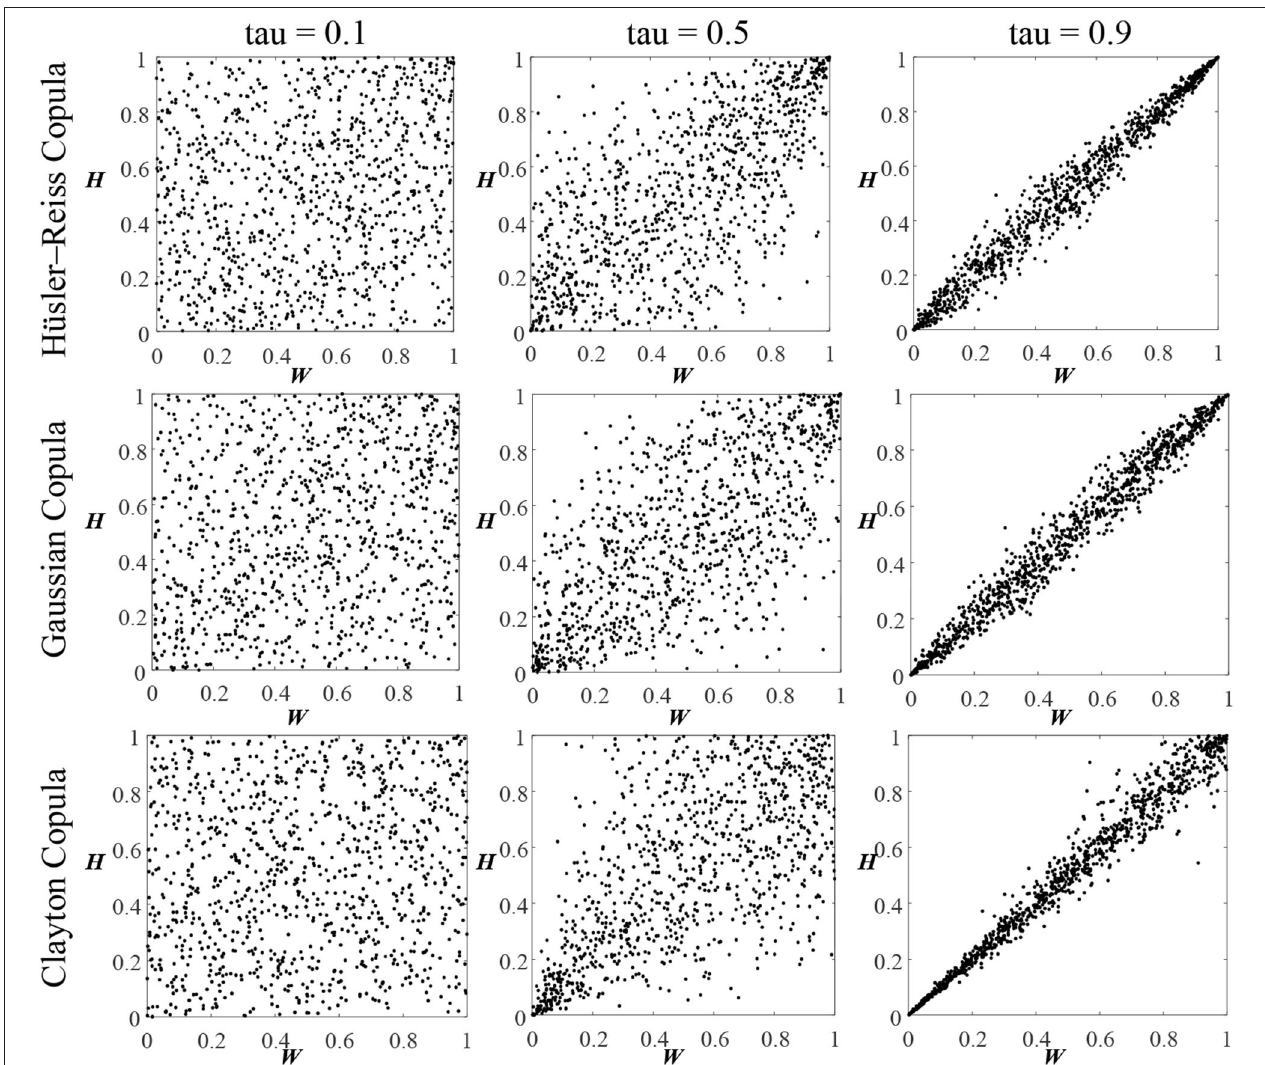
FIGURE 5 | Samples of correlated H and W in the copula domain using Hüsler-Reiss, Gaussian, and Clayton copula functions considering Kendall’s tau equal to 0.1, 0.5, and